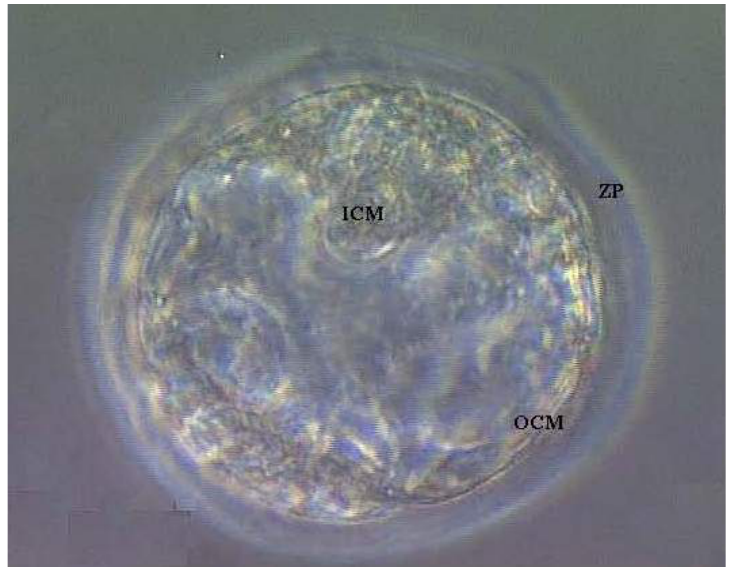
Figure 6. Photomicrograph of a blastocyst with an outer cell mass (OCM), inner cell mass (ICM) encompassed by an intact zona pellucida (ZP; Magnification = 400X).